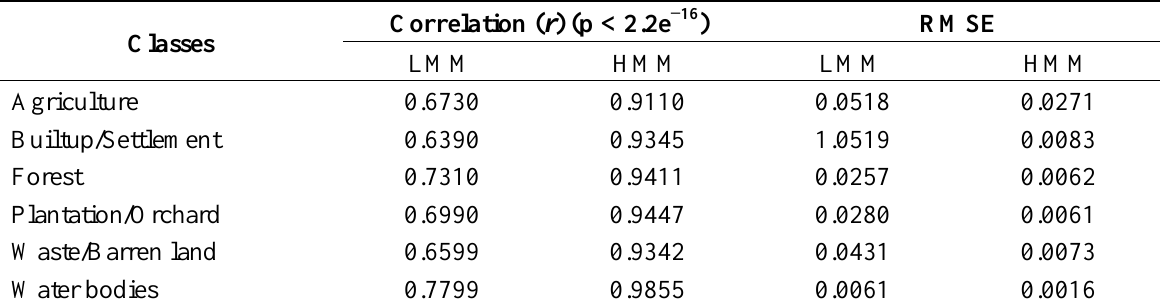
Table 4. Correlation and RMSE between real/reference and predicted proportions for MODIS